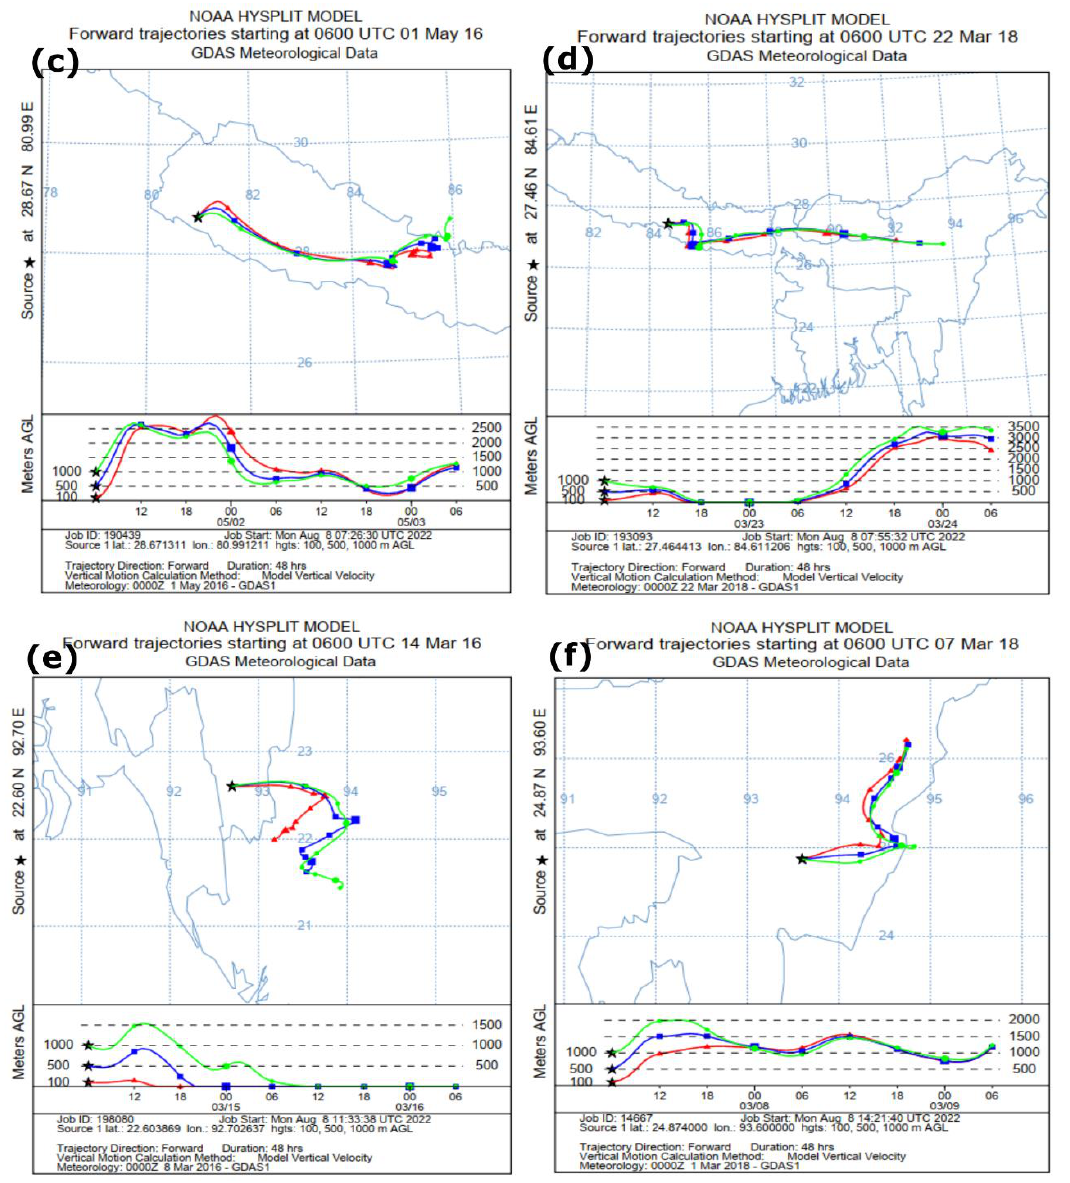
Figure 9. Forward Hybrid Single-Particle Lagrangian Integrated Trajectory model (HYSPLIT) on high forest fire locations of 2016 and 2018 over western Himalaya ( a , b ), Nepal ( c , d ), and eastern Himalaya ( e , f